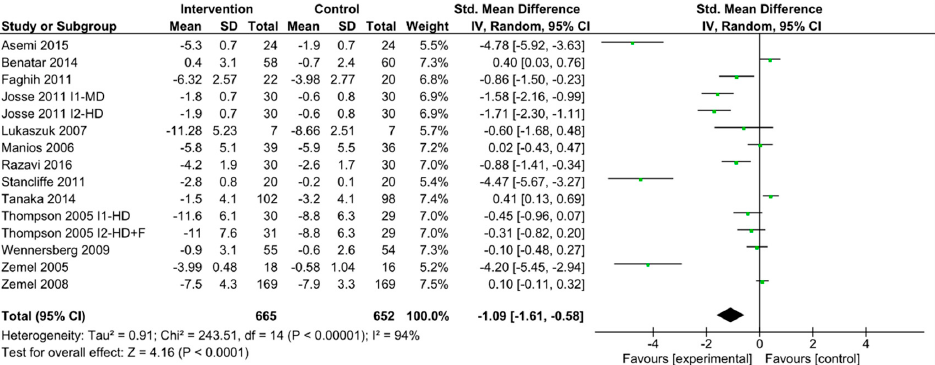
Figure 4. Forest plot of randomized clinical trials of dairy intake and waist circumference. Waist circumference change measured in cm. Abbreviations: F, fiber; HD, high dairy diet; MD, moderate dairy diet.